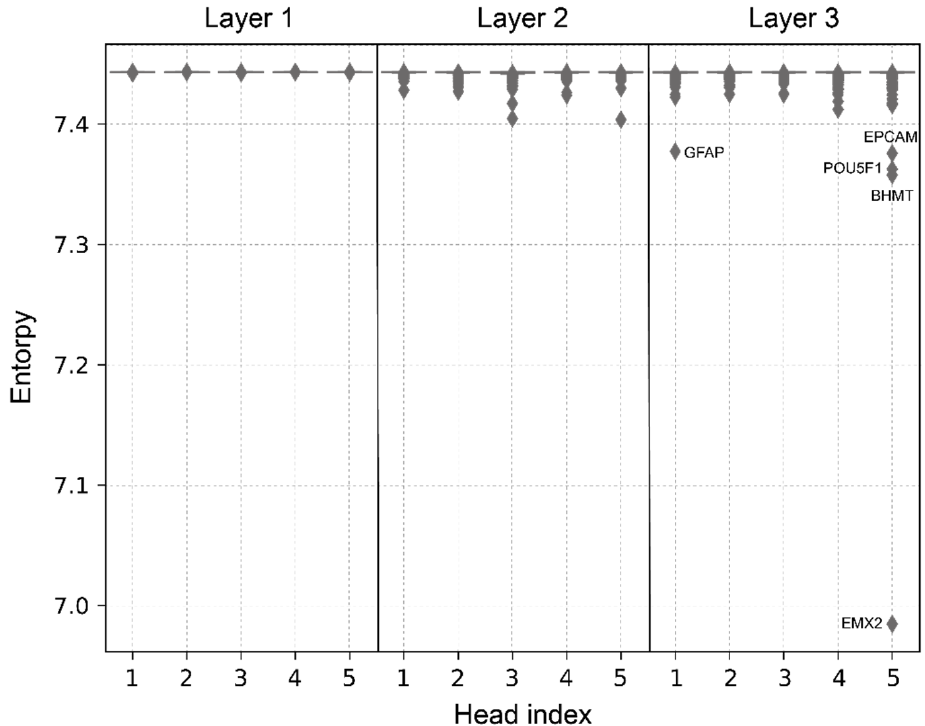
Figure 2. Entropies of each head’s attention weights. Dot plots for different layers are split by black lines. Each dot represents the average entropy value for one query gene.